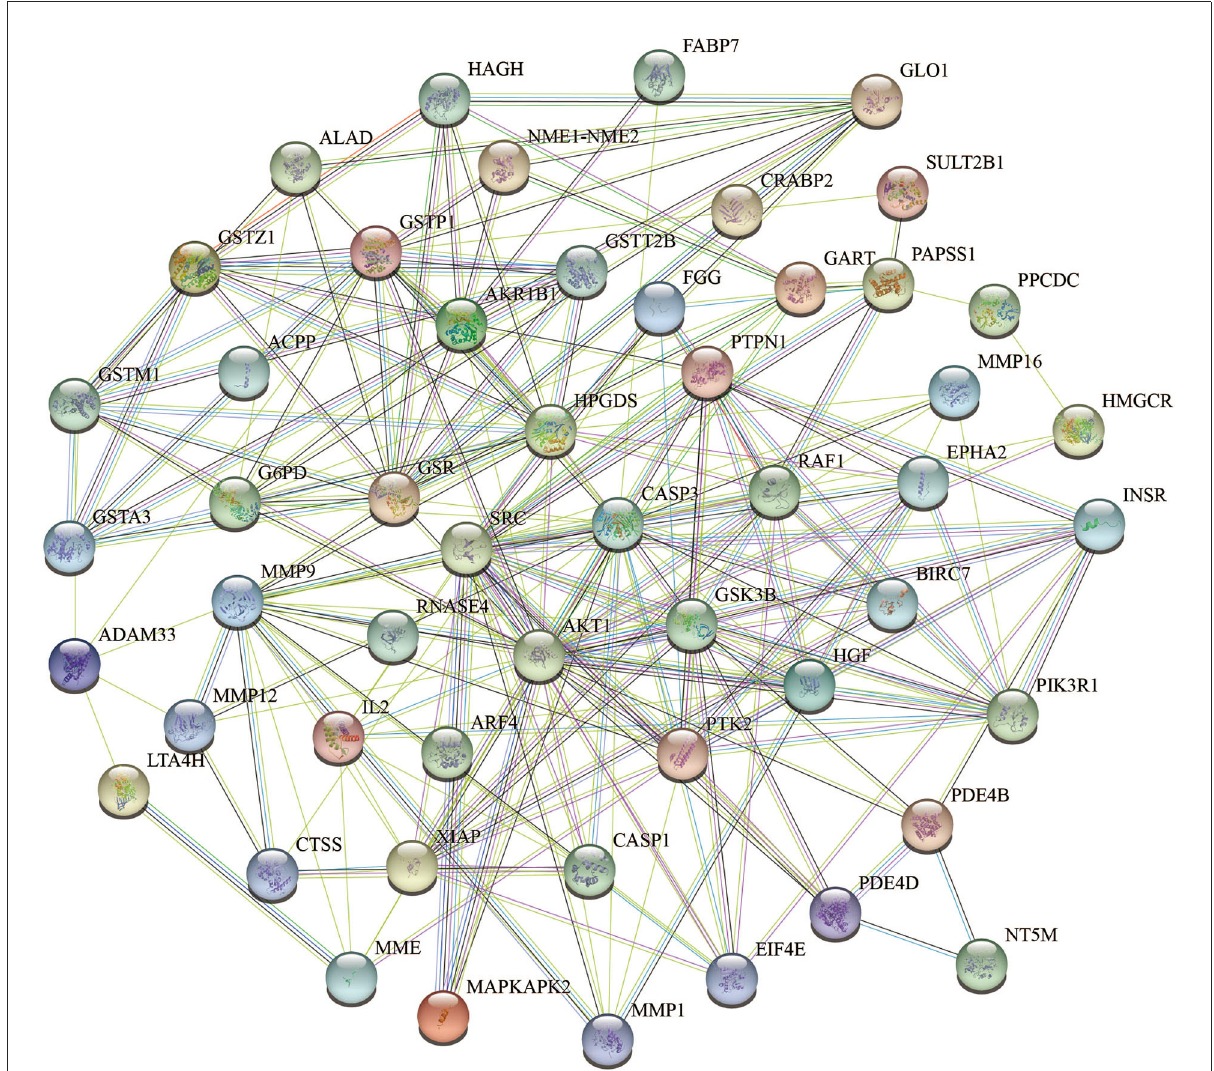
FIGURE3 Protein-protein interaction (PPI) network of the targets could be regulated by fermented egg-milk peptides (FEMPs). The nodes represented for the targets, and the edges represented for the interactions between the